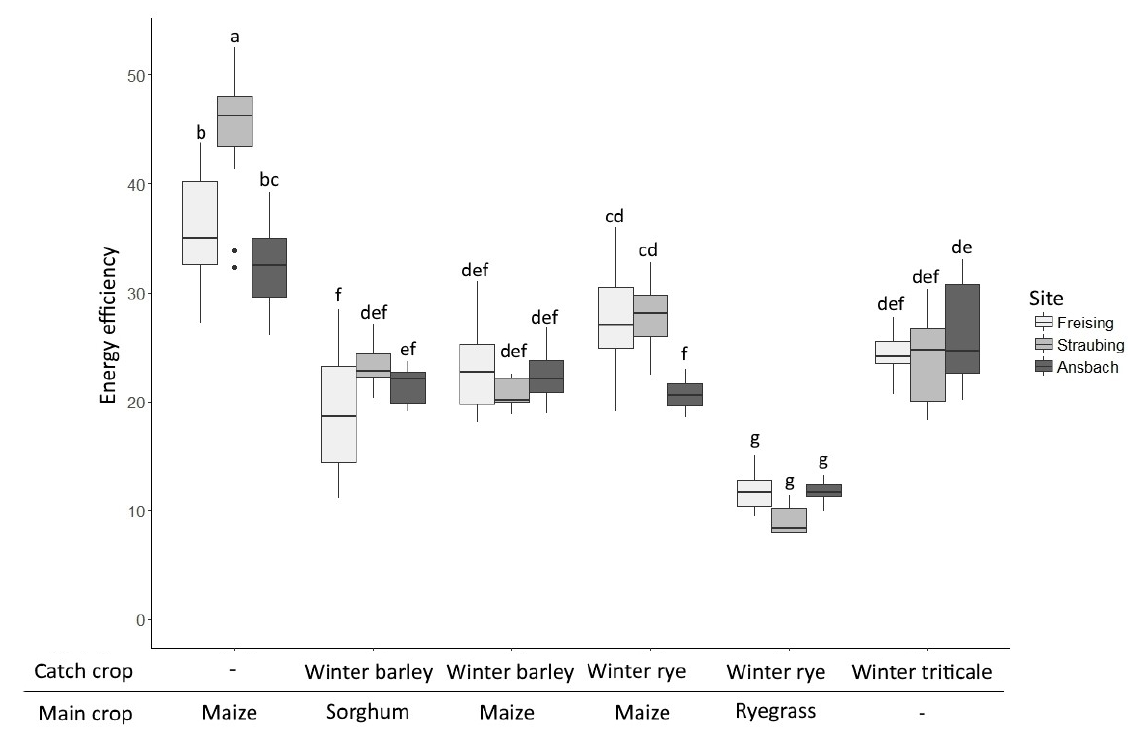
Figure 4. Mean energy efficiency across sites and trial years (2007–2010). Different letters indicate significant differences. Points indicate outliers.